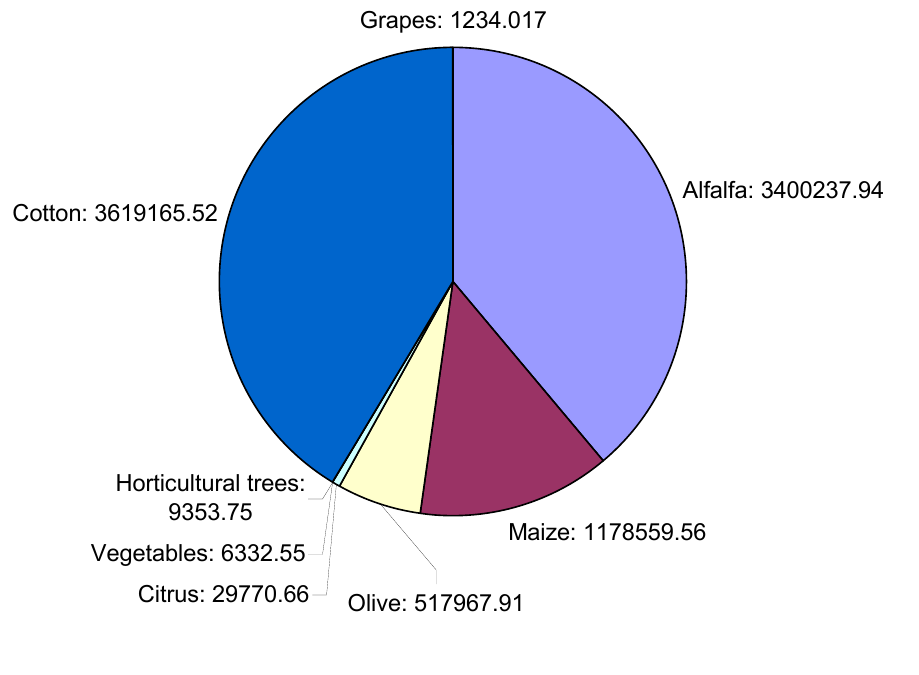
Figure 7. Water volume (m 3 yr -1 ) that is required per crop in Messologhion